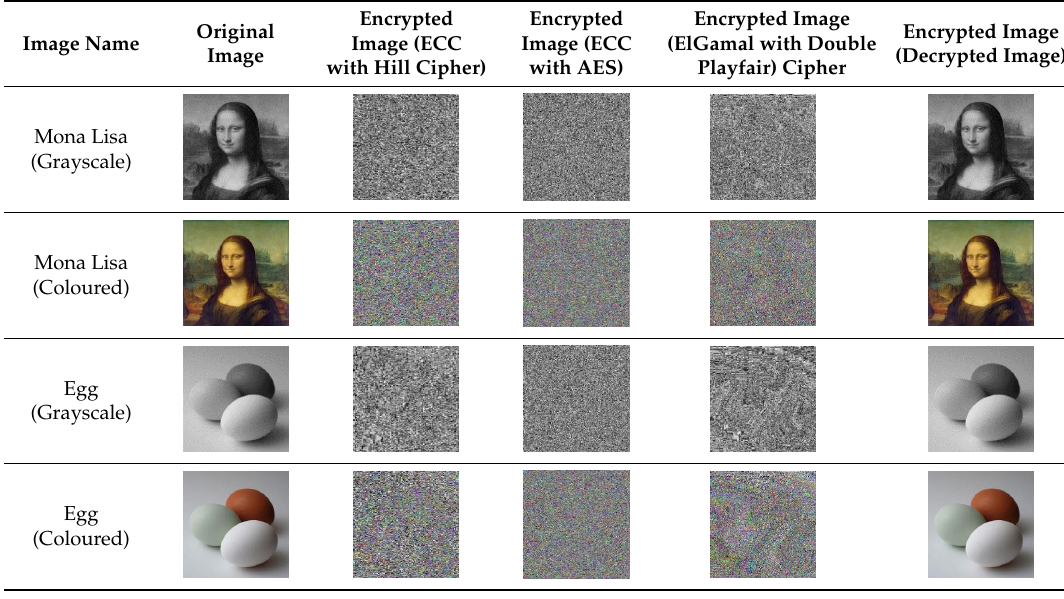
Table 1. Sample input and output for proposed hybrid algorithms.